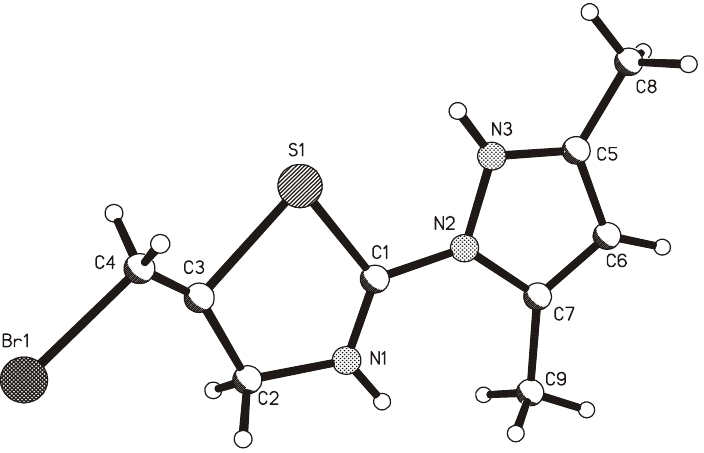
Figure 3. ORTEP representations of the compound 8 molecular structure.